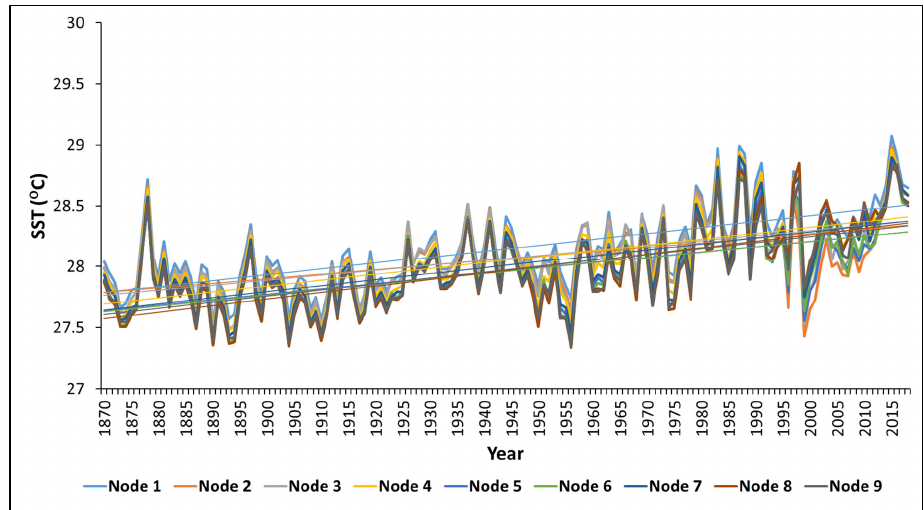
Figure 7. Average SST variation of each 1° × 1° node in the study area. The black, straight lines indicate the standard error.